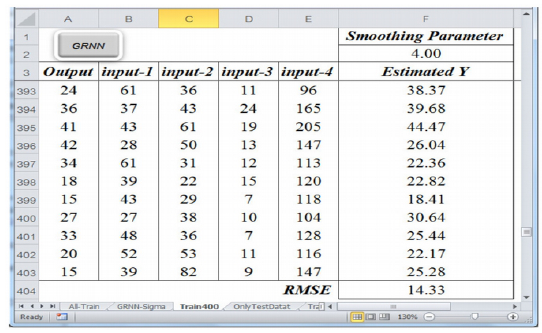
Figure 4. Output screen capture of the forecasting module using GRNN